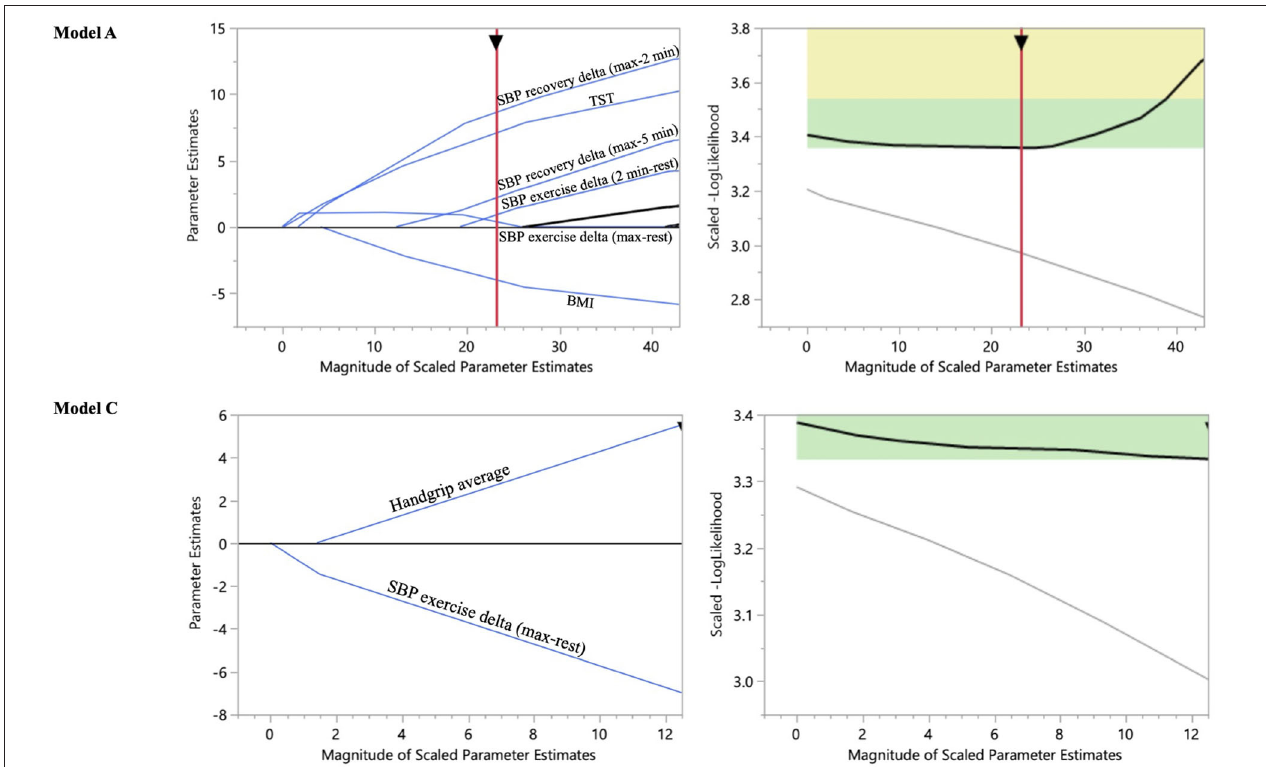
FIGURE 2 | Solution path trace plot applied to predict HRR1 increase and decrease post-maximal exercise ECG using the baseline and year 1 predictors as independent variables: Models A and C. Each line corresponds to a predictor variable. As regularization is applied to the model (from right to left in the trace plot), less important coefficients get smaller, and some are completely removed from the model (the ones that have a beta coefficient of 0 and where the line for the predictor intersects with the x-axis before the optimal solution is reached). A generalizable model was built with an eight-fold cross validation to determine the model which provides a global minimum (within the green rectangle) for the scaled-log likelihood value among the validation